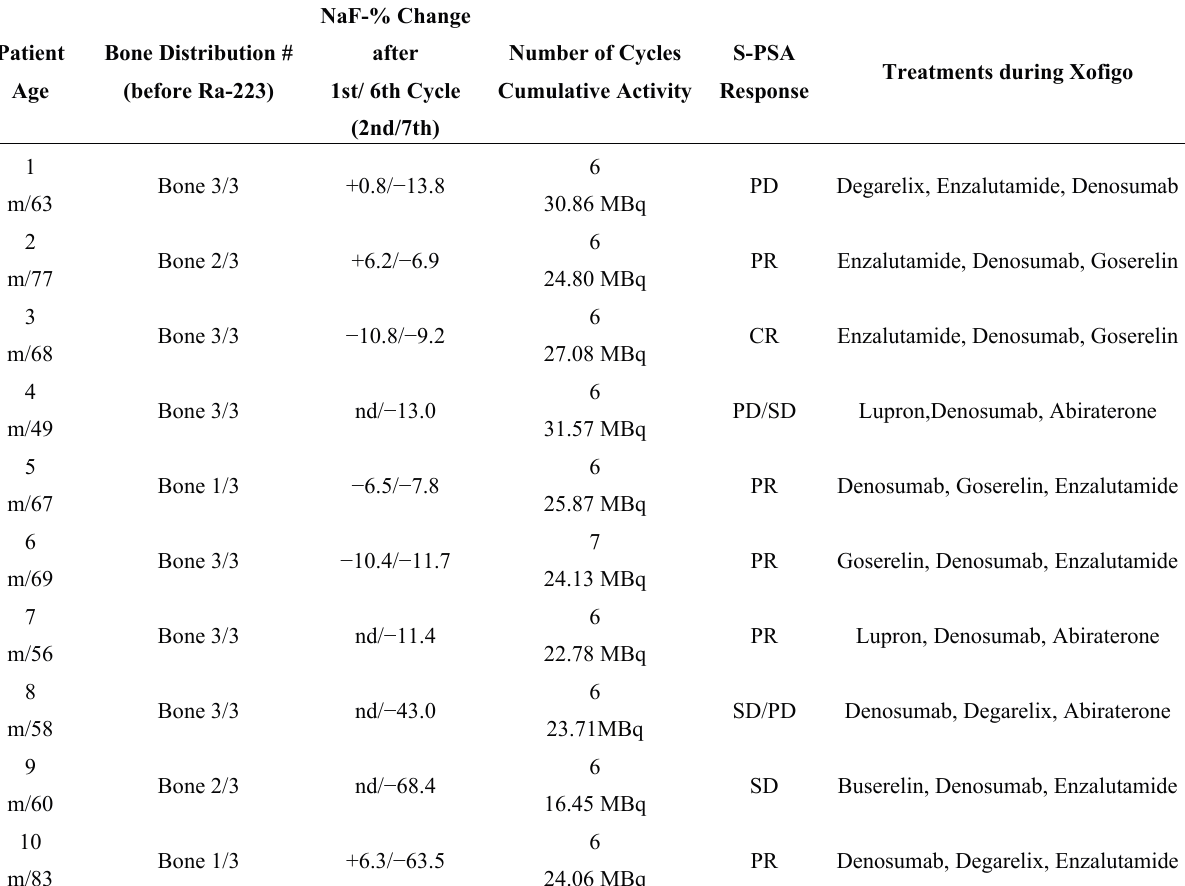
Table 2. The summary of the NaF imaging